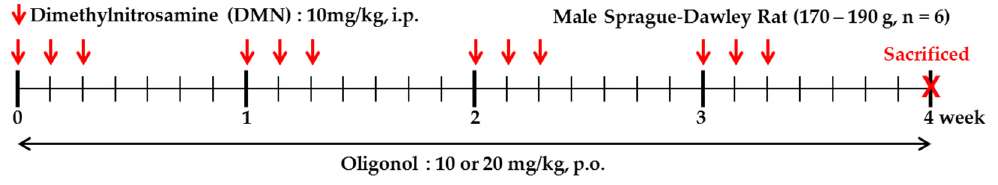
Figure 1. Treatment protocols for animal experiments.